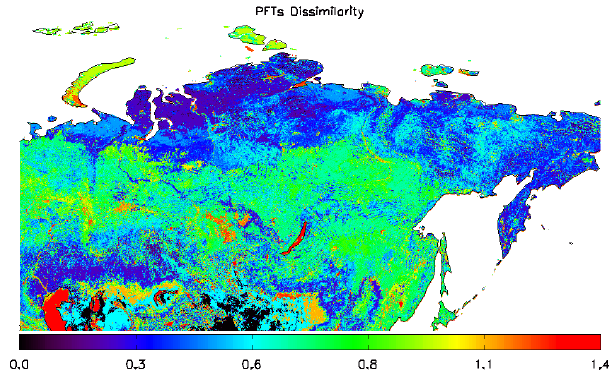
Figure 8. PFT dissimilarity index ranging from 0 (full agreement) √ to 2 (full